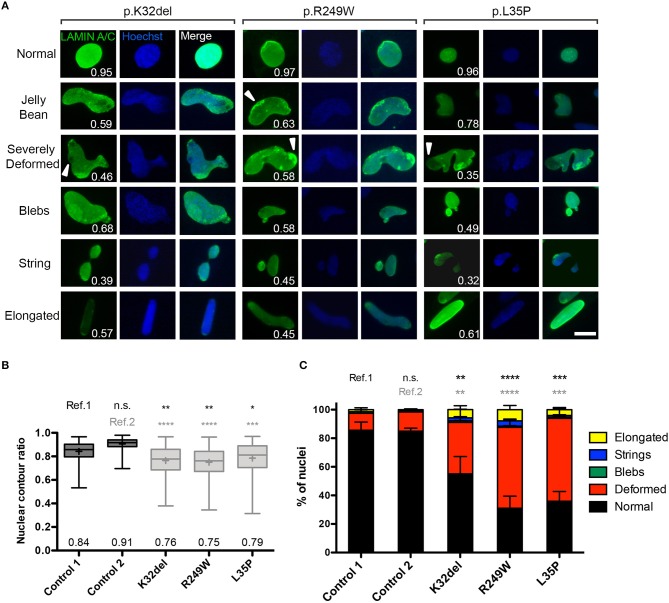
LMNA-mutant human iPSC-derived inducible myogenic cells have nuclei with abnormal morphology. (A) Representative examples of immunofluorescence showing nuclear morphology of LMNA-mutant HIDEMs K32del, R249W, and L35P (high magnification pictures from Figure 1B). Abnormal nuclear morphologies were classified into five categories: jelly bean, severely deformed, blebs, string or elongated, and examples of each are shown for each cell line, with their corresponding nuclear contour ratio values. Cells with normally-shaped circular/oval nuclei typically have a nuclear circularity of 1–0.79, whereas nuclear deformity reduces this ratio (indicated on each panel). Some mislocalization of Lamin A/C is also evident (white arrowheads). Scale bar: 20 μm. (B) Nuclear deformity in LMNA-mutant HIDEMs quantified using the nuclear contour ratio. One-way analysis of co-variance (ANOVA) with Tukey's post-hoc comparisons performed on the average values of the three repeats compared to each control line (n = 3, 152–334 nuclei assessed per repeat passage for each cell line); *p < 0.05, **p < 0.01, ***p < 0.001, ****p < 0.0001. Data are box plots generated from all circularity values across three repeats combined (a total of 663–755 nuclei were analyzed per cell line); whiskers: minimum and maximum values, +: average (specified also at the bottom of each column). (C) Quantification of prevalence of nuclear shape abnormalities, as well as normal shaped nuclei (circular or oval). Nuclei were considered elongated if they were >25 μm along their major axis. When present, nuclei with more than one type of abnormality were counted twice (e.g., blebs and elongated), so totals can exceed 100%. Number of normal shaped nuclei was compared between LMNA-mutant HIDEMs and control 1 (ref.1) and control 2 (ref.2). Between 81 and 167 nuclei were analyzed per cell line per repeat, apart from one repeat of control 1 where only 51 nuclei were assessed (a total of 248–355 nuclei were assessed per cell line). Statistics were performed on the average values of the three repeats (n = 3) compared to each control line, using one-way analysis of co-variance (ANOVA) with Tukey's post-hoc comparisons; *p < 0.05, **p < 0.01, ***p < 0.001, ****p < 0.0001.